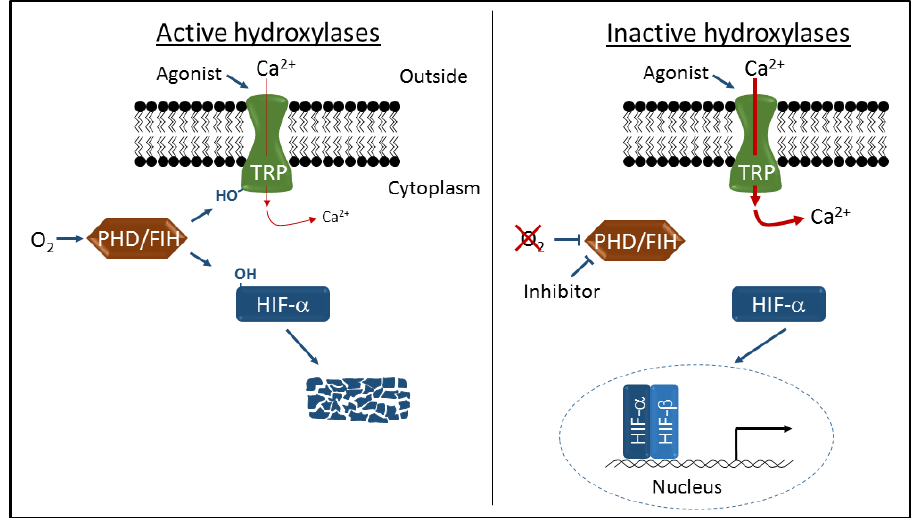
Figure 1. Schematic representation of transient receptor potential (TRP) channel and hypoxia-inducible factor (HIF) regulation by the prolyl hydroxylase containing enzymes (PHD) and asparaginyl hydroxylase factor inhibiting HIF (FIH) hydroxylases. Oxygen-dependent hydroxylation (-OH) of TRPA1 and TRPV3 channels inhibits cation entry through activated channels, and hydroxylation of HIFα proteins leads to proteolytic degradation and transcriptional repression. Inhibition of hydroxylase activity by hypoxia or specific inhibitors leads to increased cation entry and robust HIF-dependent gene activation.